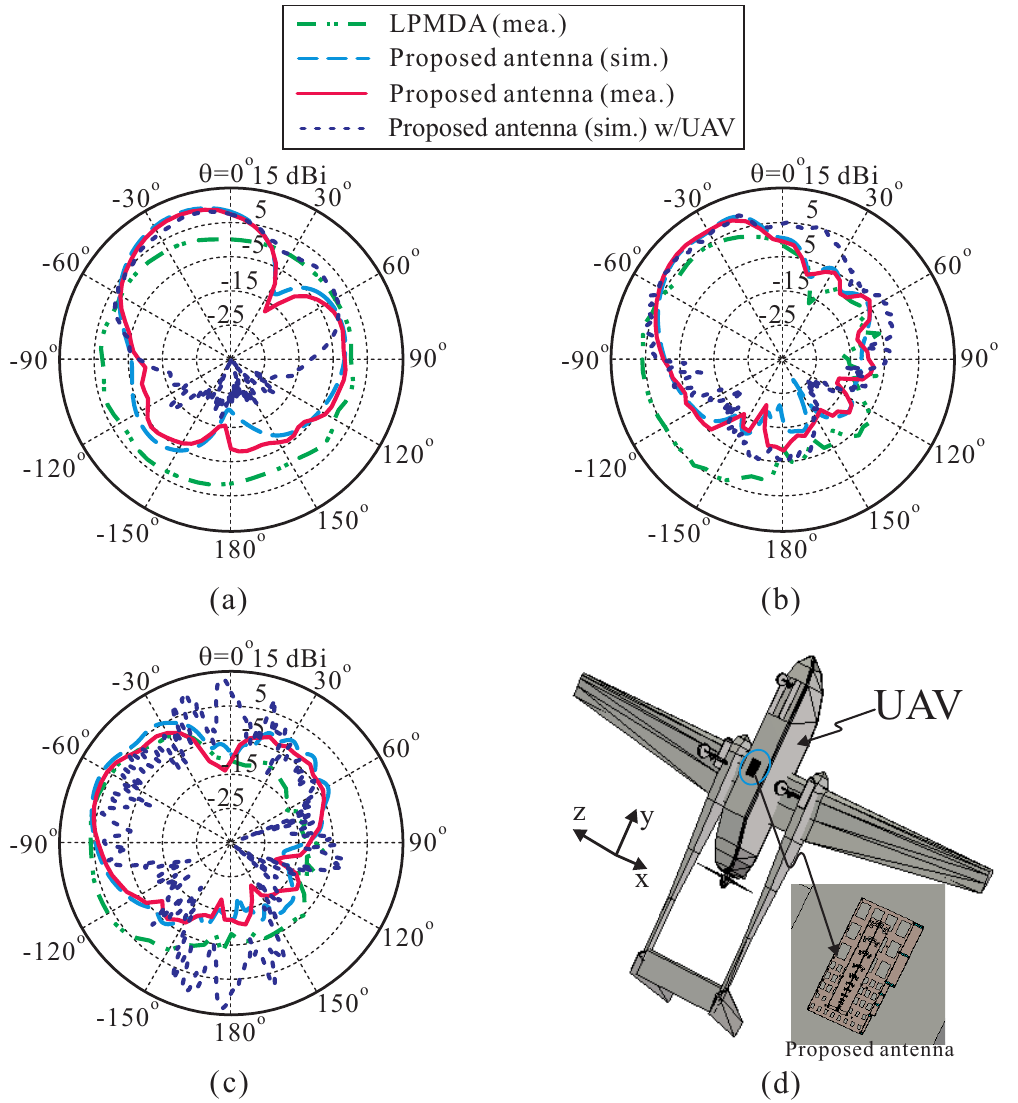
Figure 9. Simulated and measured radiation patterns of the proposed AMC-backed LPMDA antenna on the yz -plane: ( a ) at 1.0 GHz; ( b ) at 3.0 GHz; ( c ) at 4.5 GHz; ( d ) Simulation model of the proposed AMC-backed LPMDA antenna mounted below the unmanned aerial vehicle (UAV)